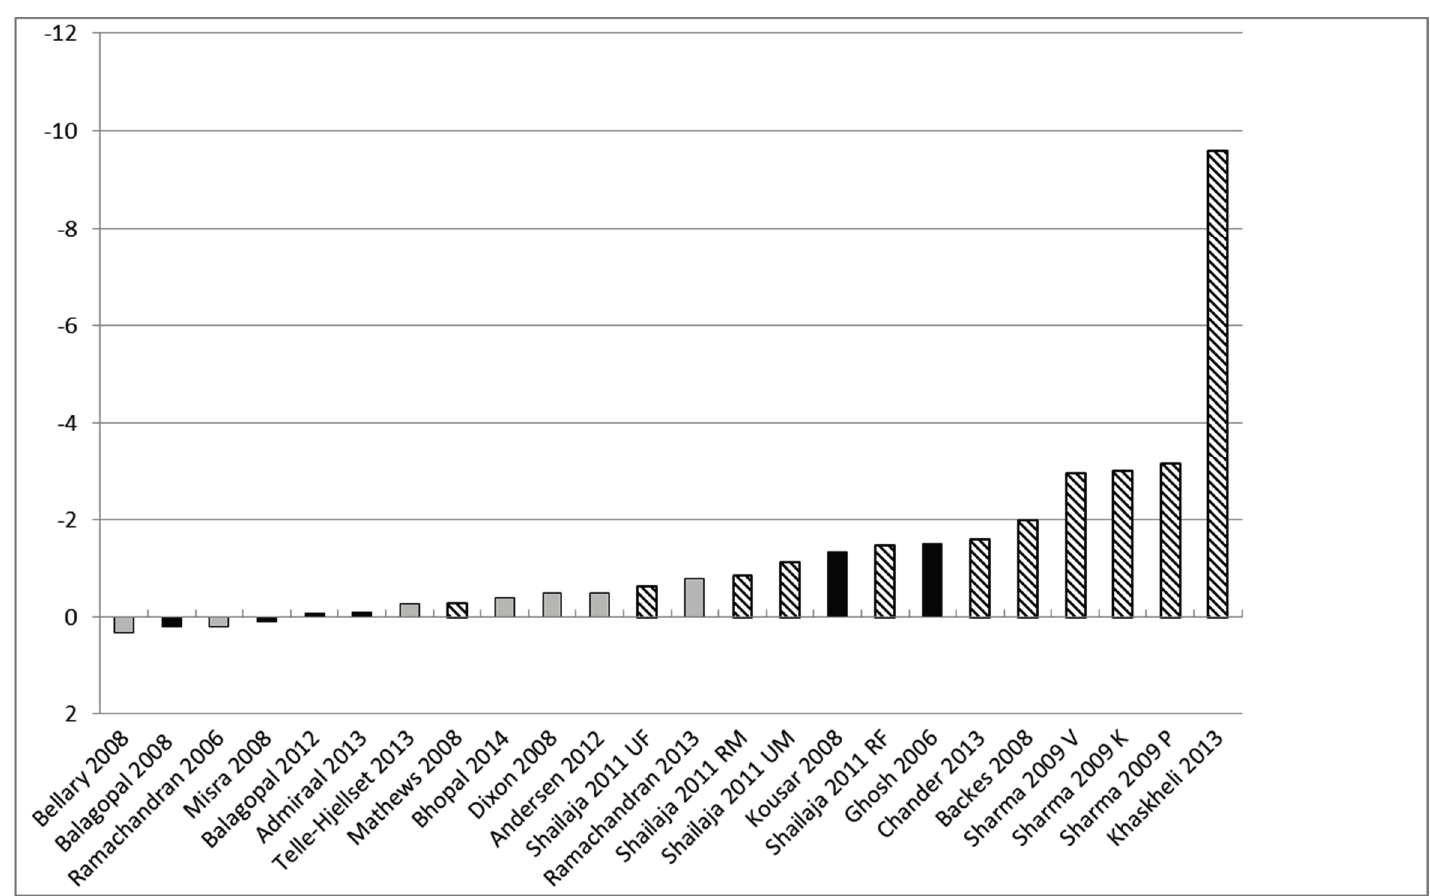
Figure 3. Mean change in BMI for adults from baseline to follow-up for intervention groups. grey = high quality (quality score 5–6); black = medium quality (quality score 3–4); pattern = low quality (quality score